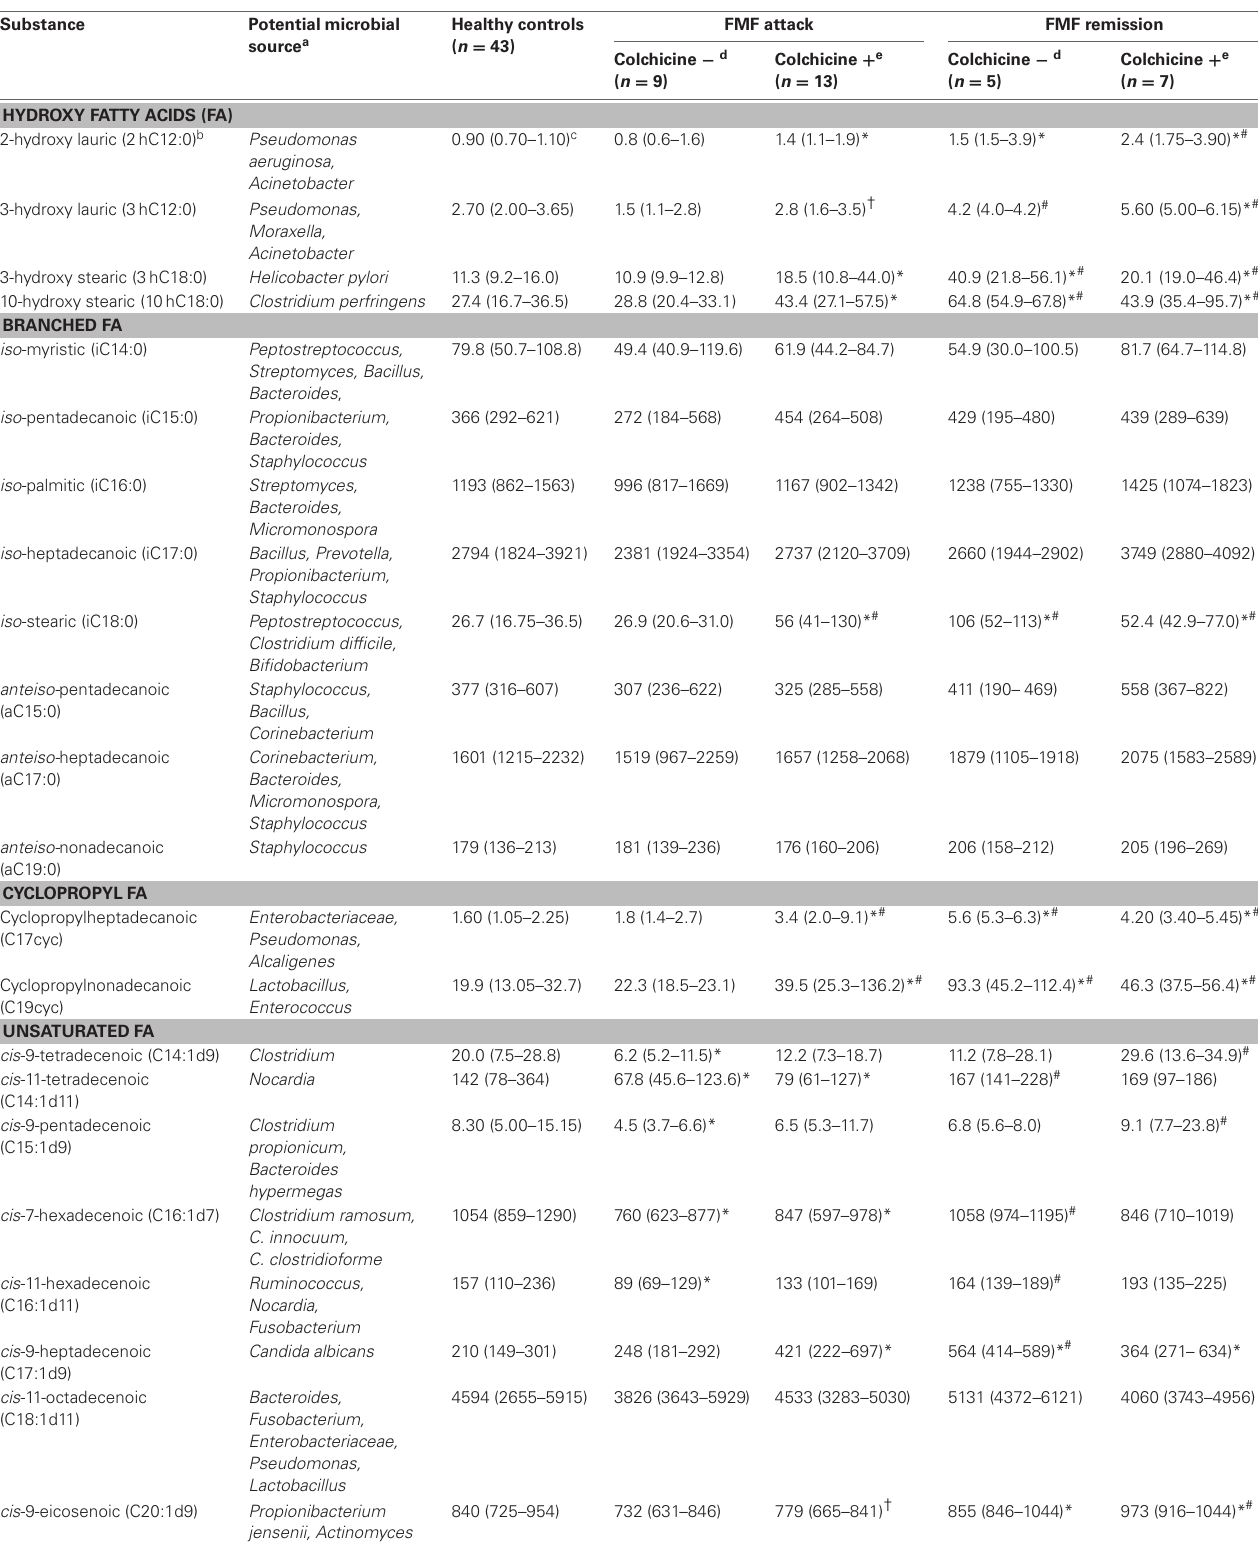
Table 1 | Concentration of microbial compounds and the potential source in blood of FMF patients and healthy controls.